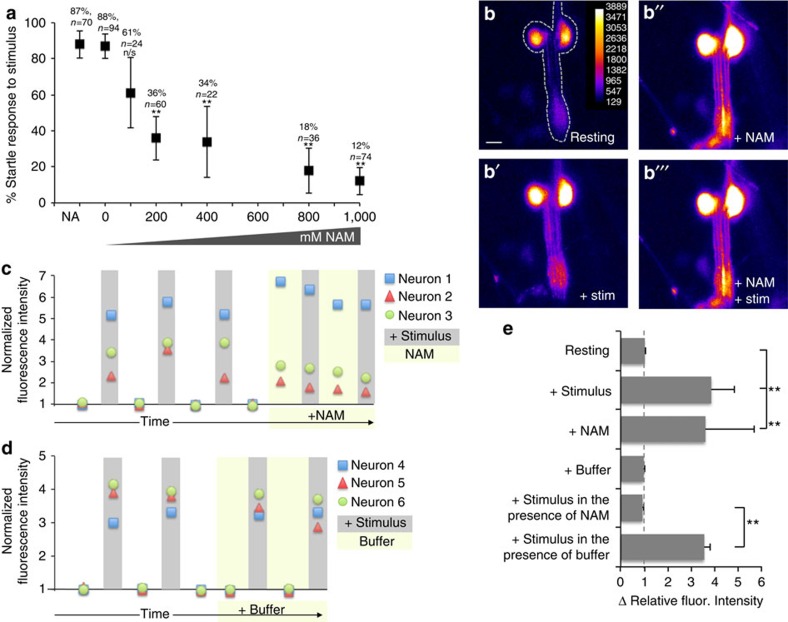
NAM affects Drosophila chordotonal neuron dependent phenotypes.(a) Third instar larva were pretreated with different concentrations of NAM or 1 M NA as a control for 10 min then exposed to a 500 Hz tone at 90 dB and scored according to presence or absence of a startle response. Data are presented as percentage of startle responses to the stimulus. Error bars are 95% confidence intervals. Actual percentages and sample sizes are indicated above each bar. For statistical analysis, P values for six pairwise comparisons to 0 mM NAM were calculated using Fisher's exact test followed by a Bonferroni correction. **Bonferroni adjusted P<0.001. (b) Fluorescence intensity of chordotonal neurons expressing GCaMP6 (b) increases in response to mechanical stimulus (b′), increases in response to application of 1 M NAM (b′′), but fails to further increase in response to stimulus after application of NAM (b′′′). Images are individual frames from Supplementary Movie 1. An example of the region of interest (ROI) used to quantify images is outlined in b. Scale bar is 10 μm. Fiji's ‘Fire' Heat map LUT (lookup table) has been applied to images for visualization of intensity differences. (c,d) Fluorescence intensity for each individual neuron examined is normalized to average baseline values and plotted at baseline, immediately after repeated applications of stimulus, after returning to base line, after application of NAM or buffer, and after subsequent reapplications of stimulus (spacing between stimuli is 16 s),. (e) Quantification of data from c,d. The change in normalized relative fluorescence intensity in response to stimulus, to application of buffer or NAM, and to a mechanical stimulus in the presence of NAM or buffer is plotted. Error bars are standard deviations. The dotted line marks no change. **P<0.001 calculated using a two-tailed t test with Bonferroni adjustment considering three pairwise tests.